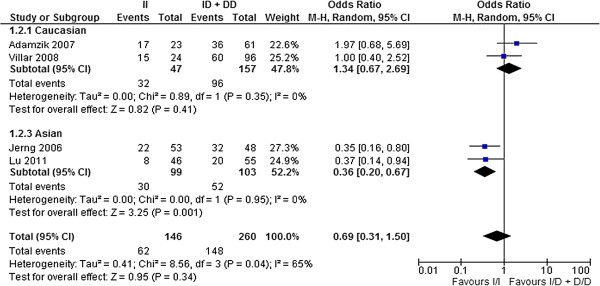
Forest plot of OR with 95% CI forACEI/D polymorphism in ALI/ARDS mortality: dominant model.